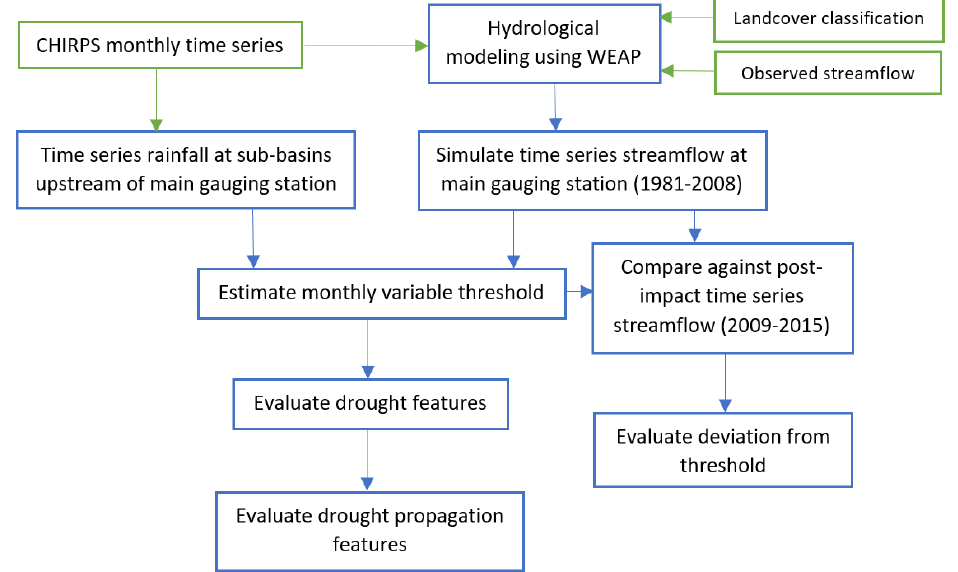
Figure 3. Approach followed for analyzing drought propagation in TRB.